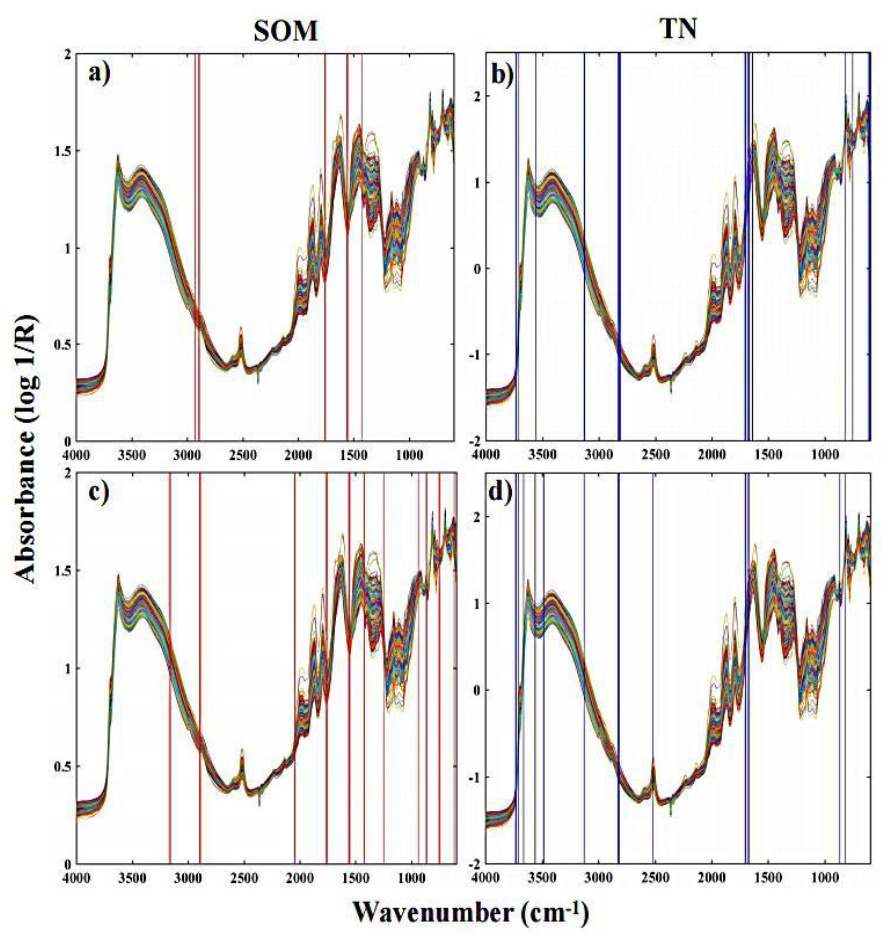
Figure 6. Characteristic variable screening chart. Note: ( a ) SOM-BOSS; ( b ) TN-BOSS; ( c ) SOM-sCARS; ( d ) TN-sCARS. R: the percentage of diffuse spectral reflectance.